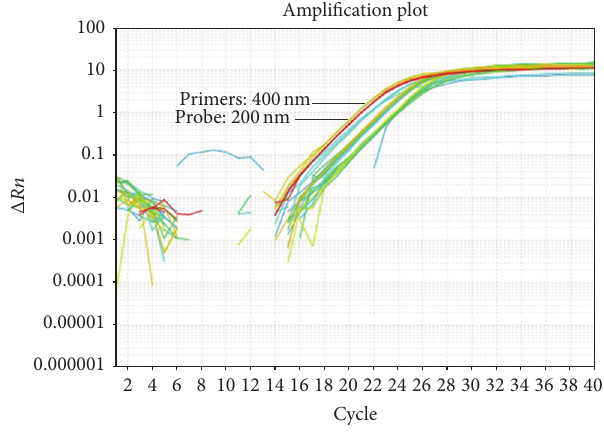
Figure 2: Optimal primers and probe used in the TaqMan real-time PCR.